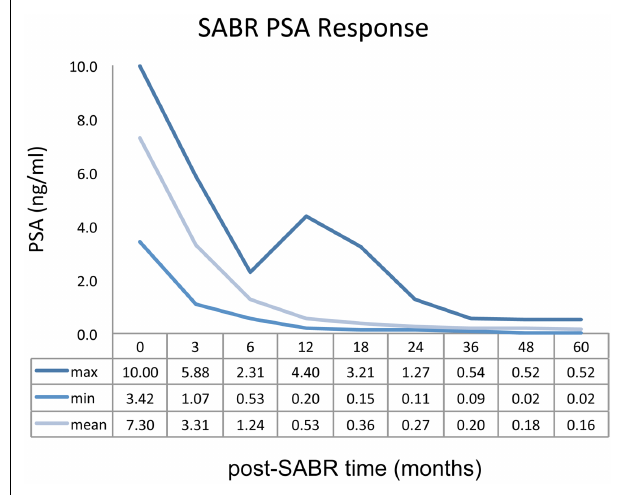
FIGURE 3 | PSA as a function of post-treatment time .